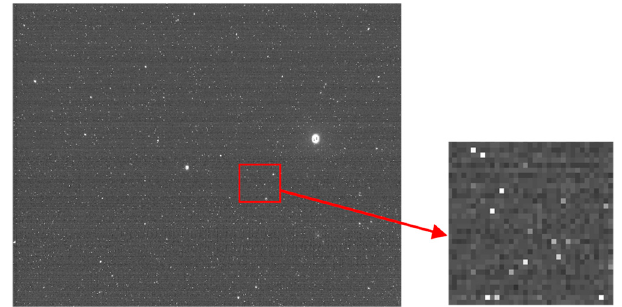
Figure 1. The noise caused by the impact of cosmic radiation particles.